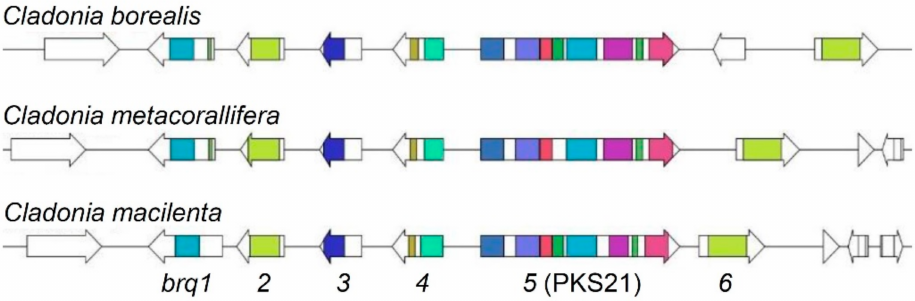
Figure 4. Synteny of biruloquinone BGCs in Cladonia species. Arrows indicate open reading frames (ORFs) found in biruloquinone BGC ( brq1 – brg6 ) loci in the three Cladonia species. Pfam domains related to secondary metabolism are color-coded in predicted ORFs (see Table